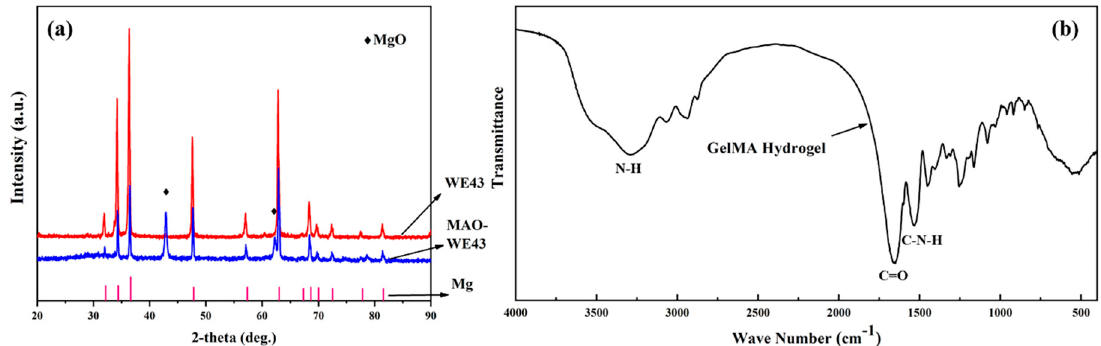
Figure 2. ( a ) XRD of WE43 and MAO-WE43, ( b ) FTIR of GelMA hydrogel.